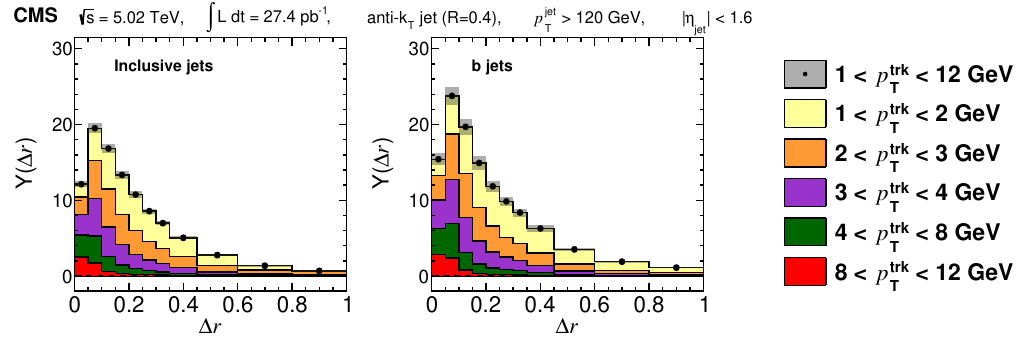
Figure 1 . Charged particle yield distributions Y (∆ r ) of inclusive (left) and b (right) jets with p > 120 GeV as functions of ∆ r are presented differentially for p trk T represent the systematic uncertainties for 1 < p trk to be visible.